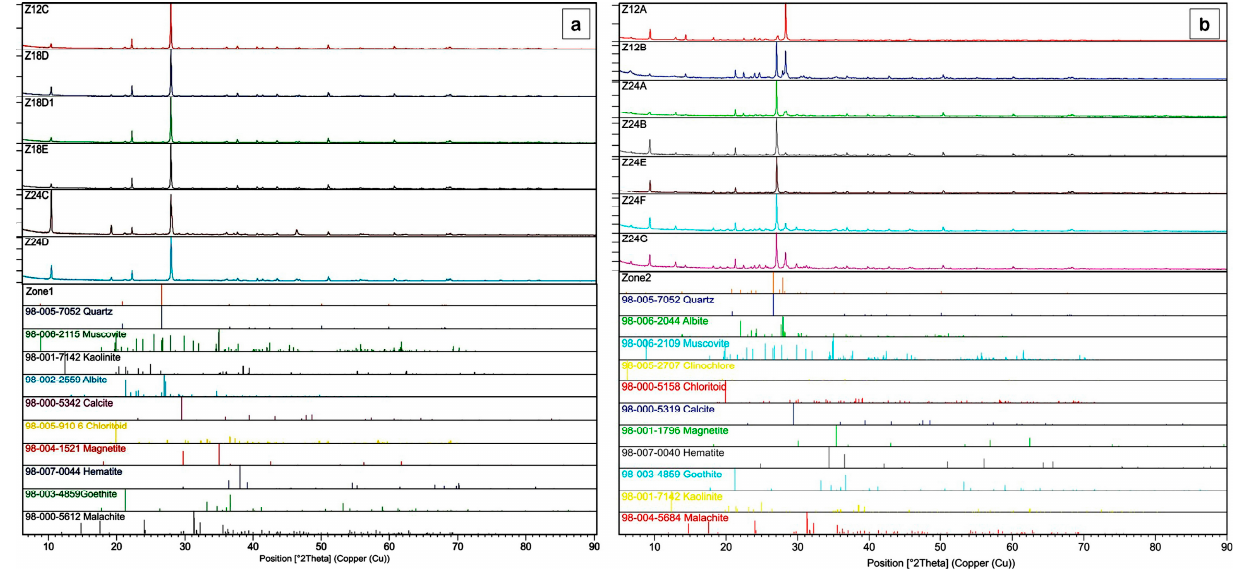
Figure 8. XRD patterns of some selected altered samples collected from the different alteration types: ( a ) Sericite-kaolinite-quartz-pyrite ± albite alteration zone-1. ( b ) Chlorite–calcite–dolomite ± albite ± sericite alteration zone-2.